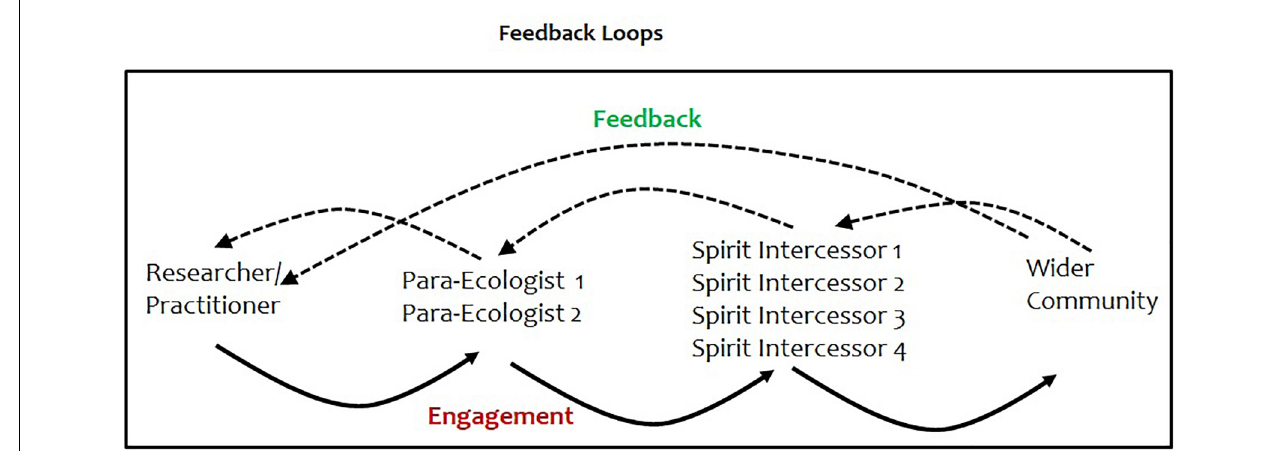
FIGURE 7 | The schematic of an engagement and feedback protocol developed for the project (Kolipaka diagram).